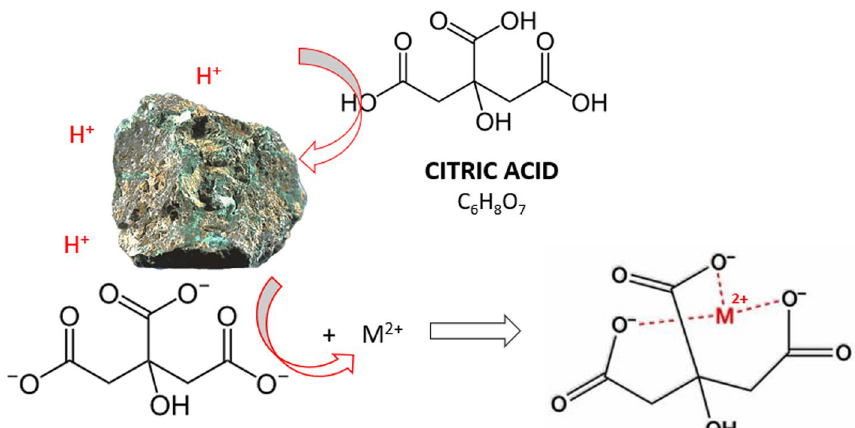
Fig. 2 Proposed mechanism for citric acid leaching and chelat- ing reactions